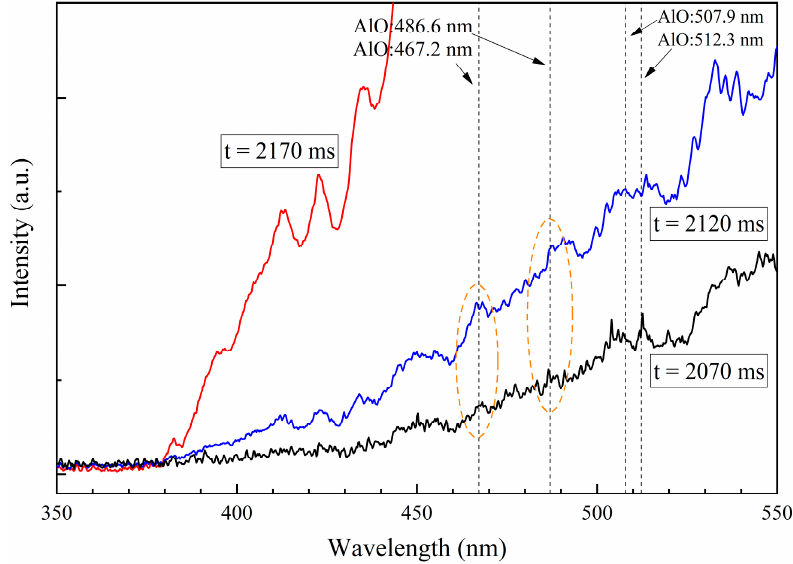
Figure 10. Representative time-resolved spectra and characteristic emission lines of AlO.